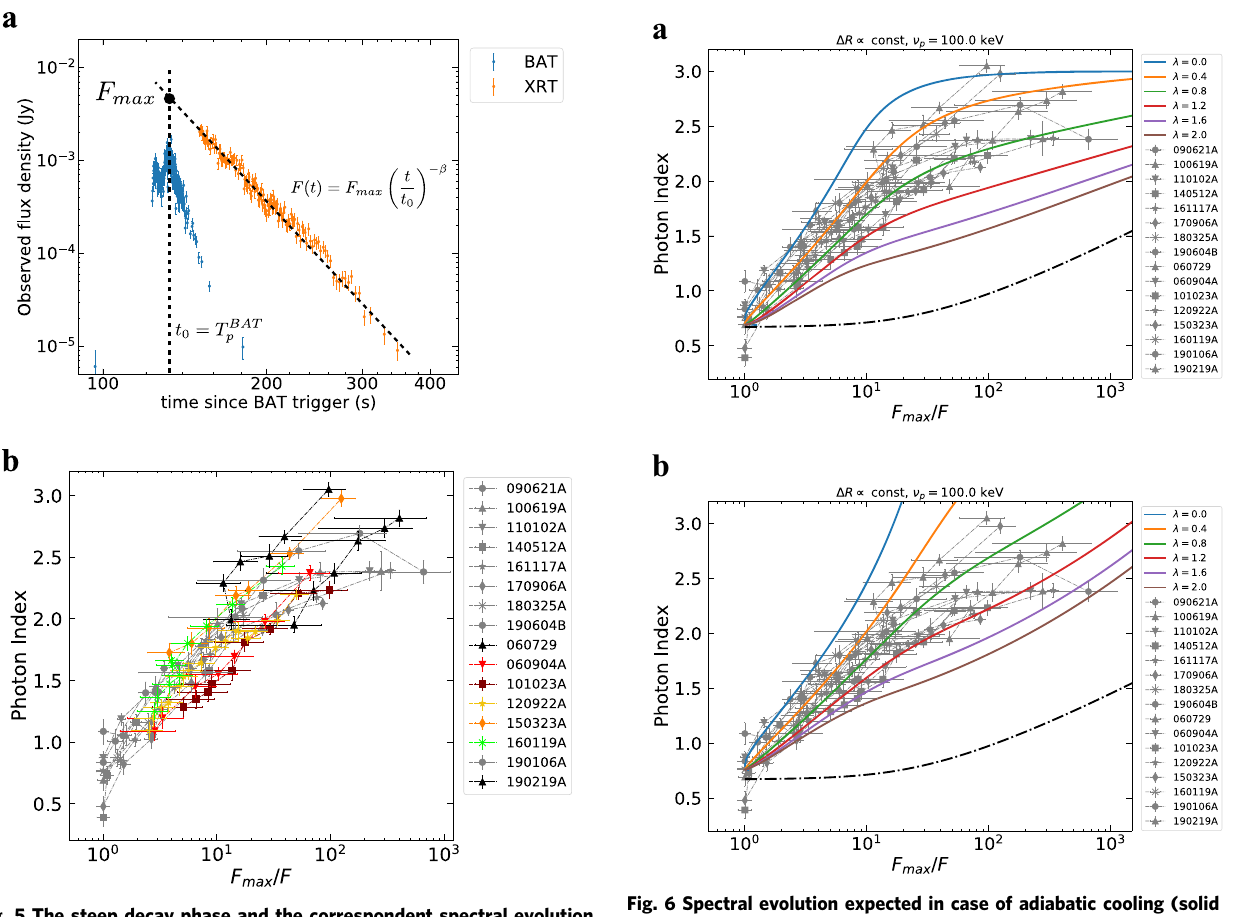
Fig. 5 The steep decay phase and the correspondent spectral evolution for the extended sample. In a we show an example of a light curve of an X- ray tail selected for our extended sample, taken from GRB 150323A. We report on the same plot the XRT (orange) and the BAT (blue) fl ux density at 1 and 50 keV, respectively. The peak fl ux F max is estimated extrapolating the X-ray tail back to the BAT peak. The error bars represent 1 σ uncertainties and they are derived from the Swift archive. In b we show the spectral evolution of our extended sample of GRBs, which present a steep decay at the beginning of the XRT light curve, preceded by the brightest BAT pulse since the trigger time. The evolution of α lies on the same region of the plane occupied by the original sample, indicated in gray. The error bars represent 1 σ uncertainties, calculated via spectral fi tting in XSPEC. In the legend, we report the name of each GRB.